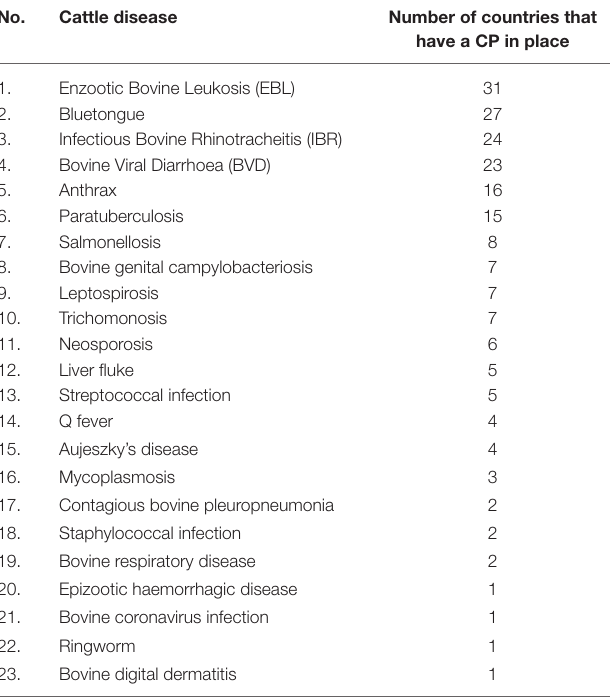
TABLE 3 | List of selected diseases with a control programme in at least one country participating in the survey and the number of countries with control programmes (CP) per